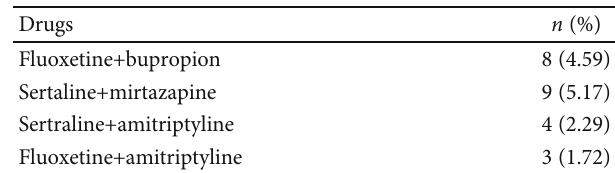
Table 3: Antidepressants prescribed as a combination therapy ( n = 174